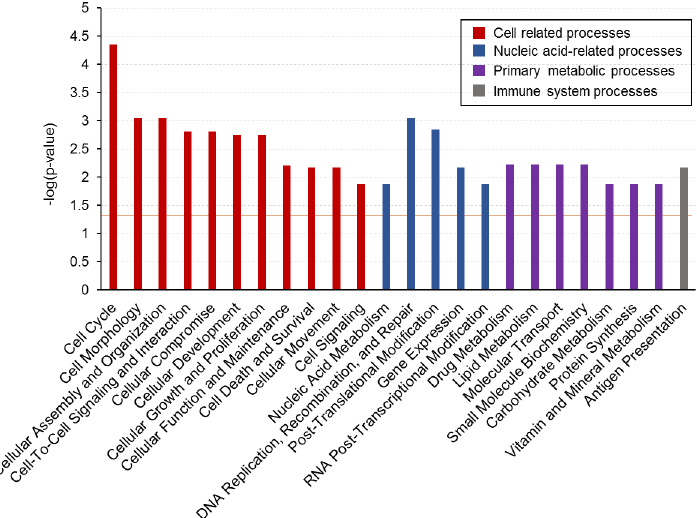
Fig 2. Molecular and functional categories associated with protein coding candidate genes. Representation of overrepresented molecular and functional categories obtained by functional analysis in IPA. Related functional categories are represented with the same color code. Only functions with a -log 10 (p-value) (cid:21) 1.3 (orange line in the graph, corresponding to a p-value (cid:20) 0.05) were